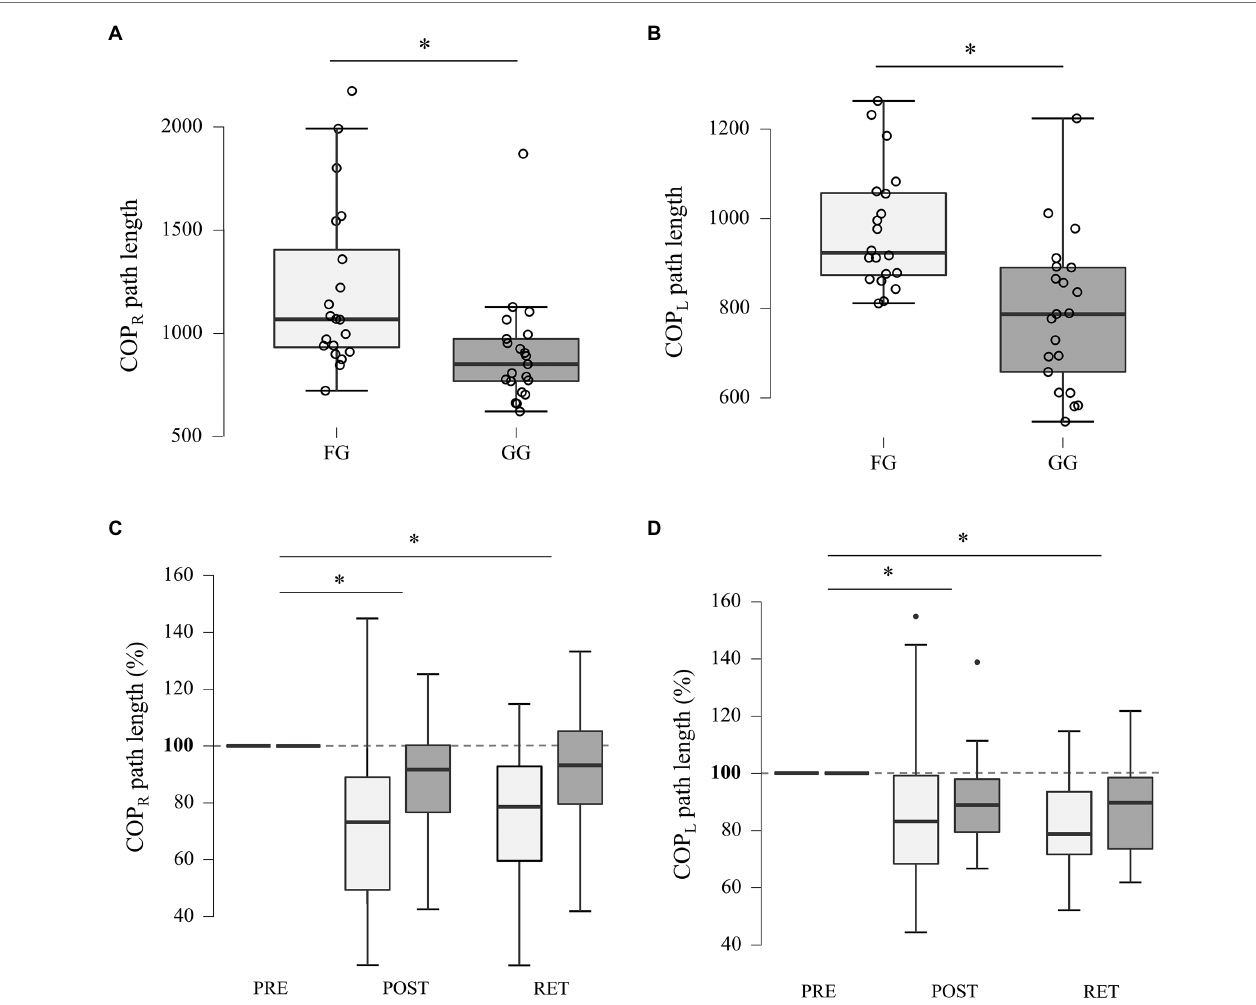
FIGURE 2 | Posturography results. (A) Group comparison of the initial performance during one-legged stance postural stability with the right leg (OLS-R). (B) Group comparison of the initial performance during one-legged stance postural stability with the left leg (OLS-L). (C) Changes in postural stability during OLS-R induced by dynamic balance training. Values obtained at POST and RET were normalized to PRE values. (D) Changes in postural stability during OLS-L induced by dynamic balance training. Values obtained at POST and RET were normalized to PRE values. * indicates significant comparison.